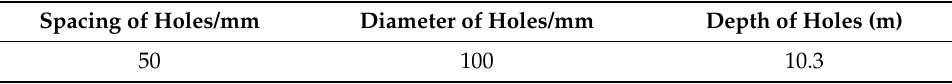
Table 2. Design parameters for the dense pressure-released holes.